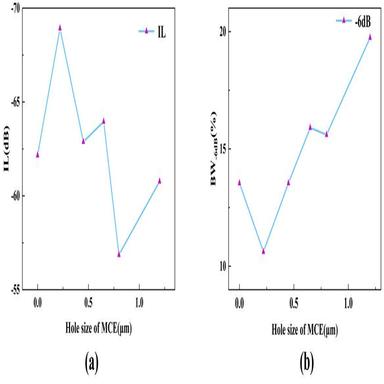
Performance of the ultrasonic transducers with varying pore sizes of MCE (a) Insertion loss(IL) and (b) –6 dB Bandwidth (BW-6 dB).